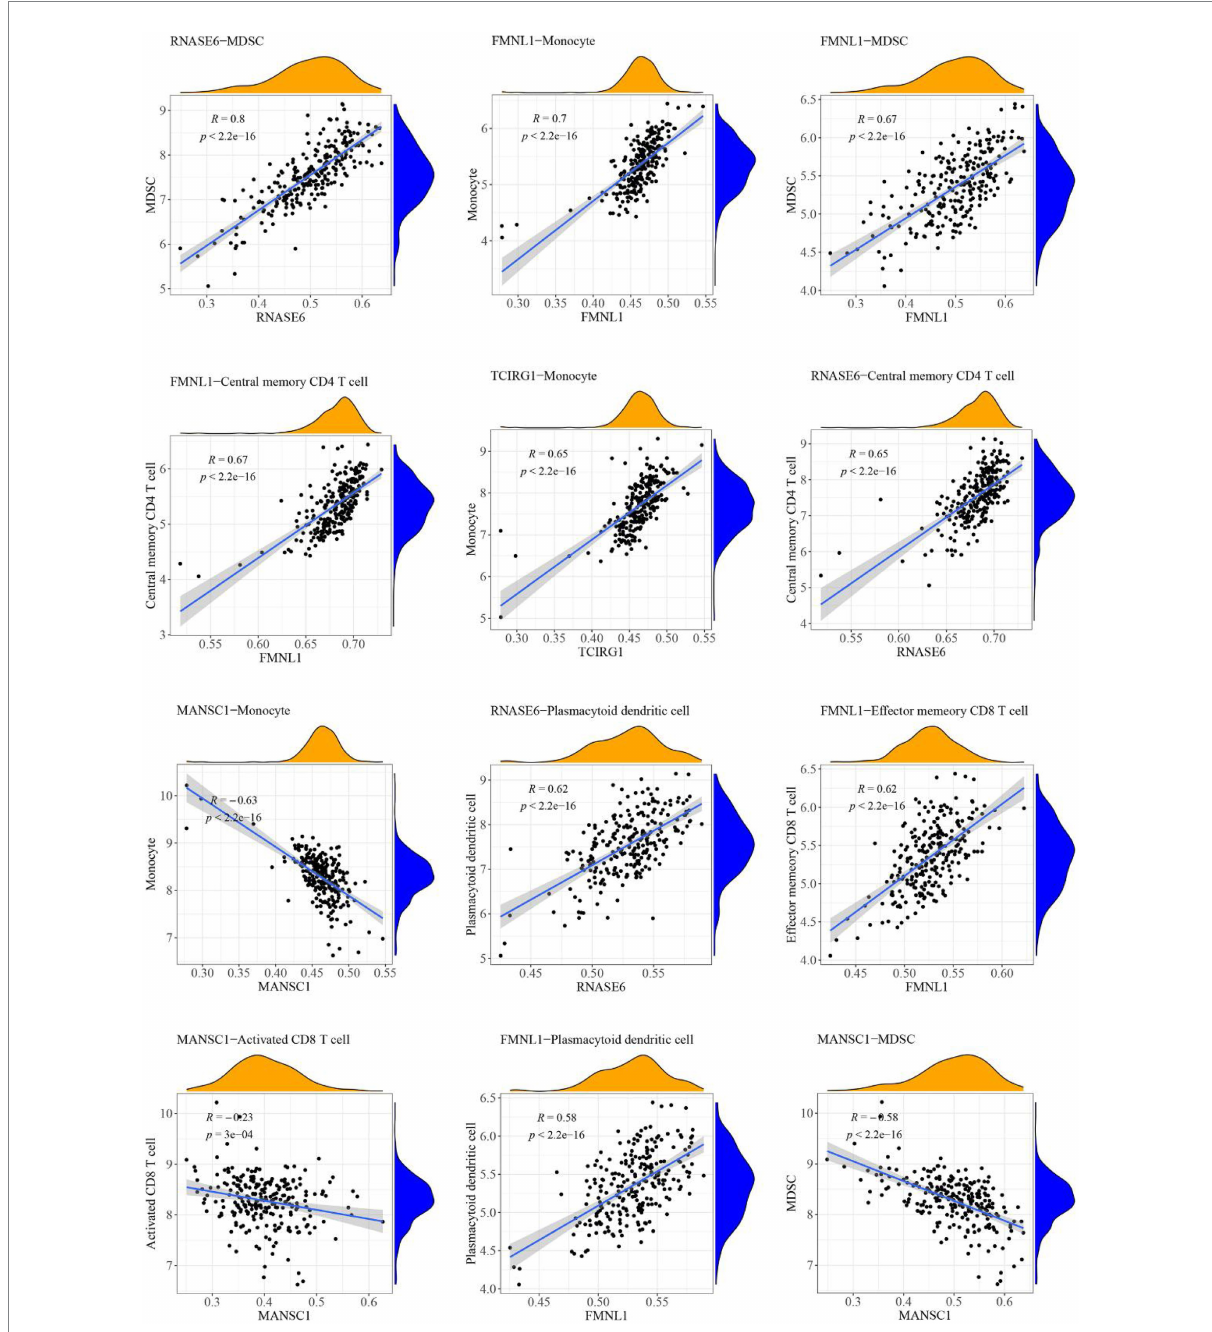
FIGURE 12 Relationship between high-abundance immune cells and hub cross-talk genes in